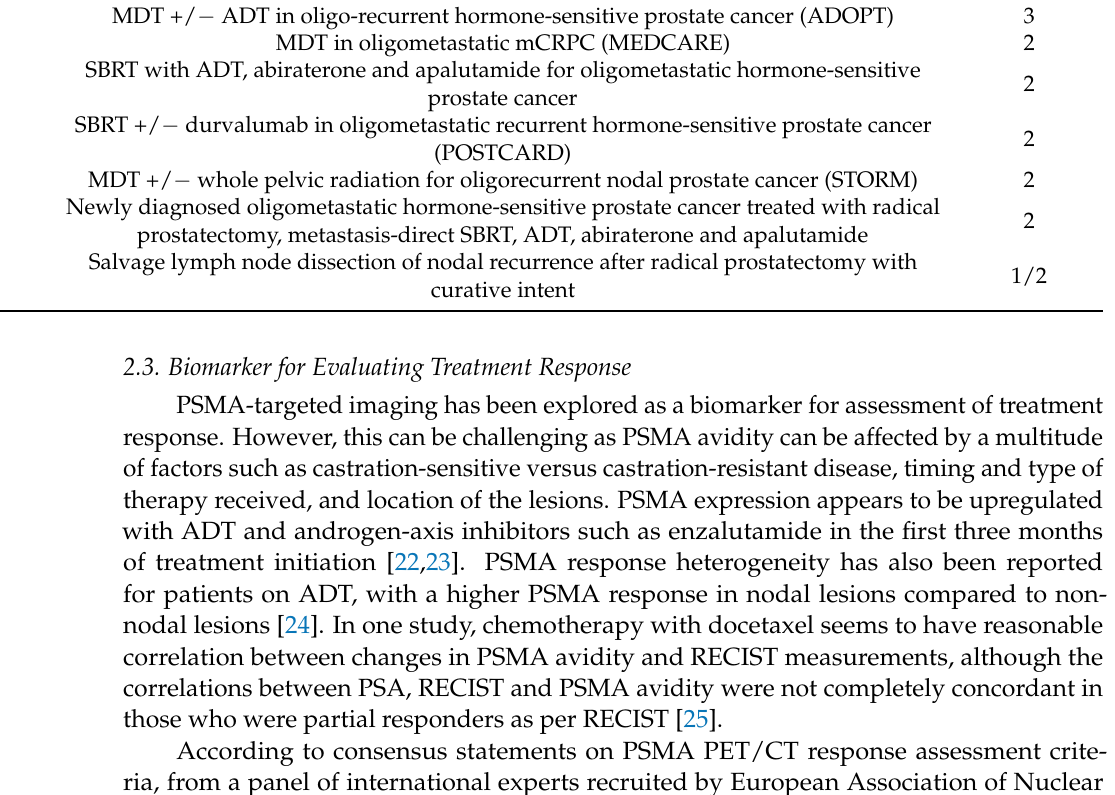
Table 1. Ongoing clinical trials in oligometastatic-directed therapy using PSMA PET imaging. Clinical Trial